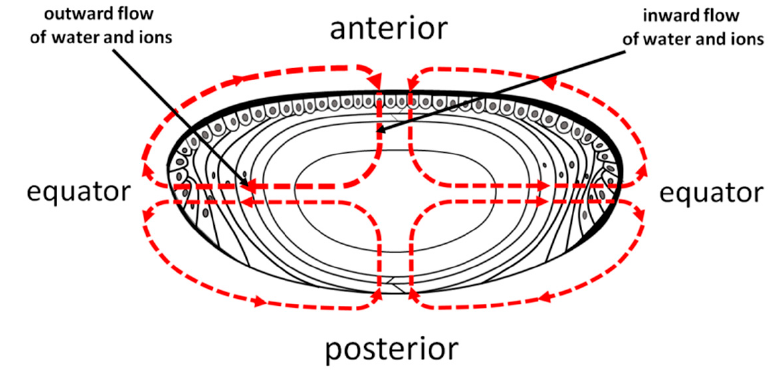
Figure 7. The internal circulatory system of the lens proposed by Donaldson et al. [60].